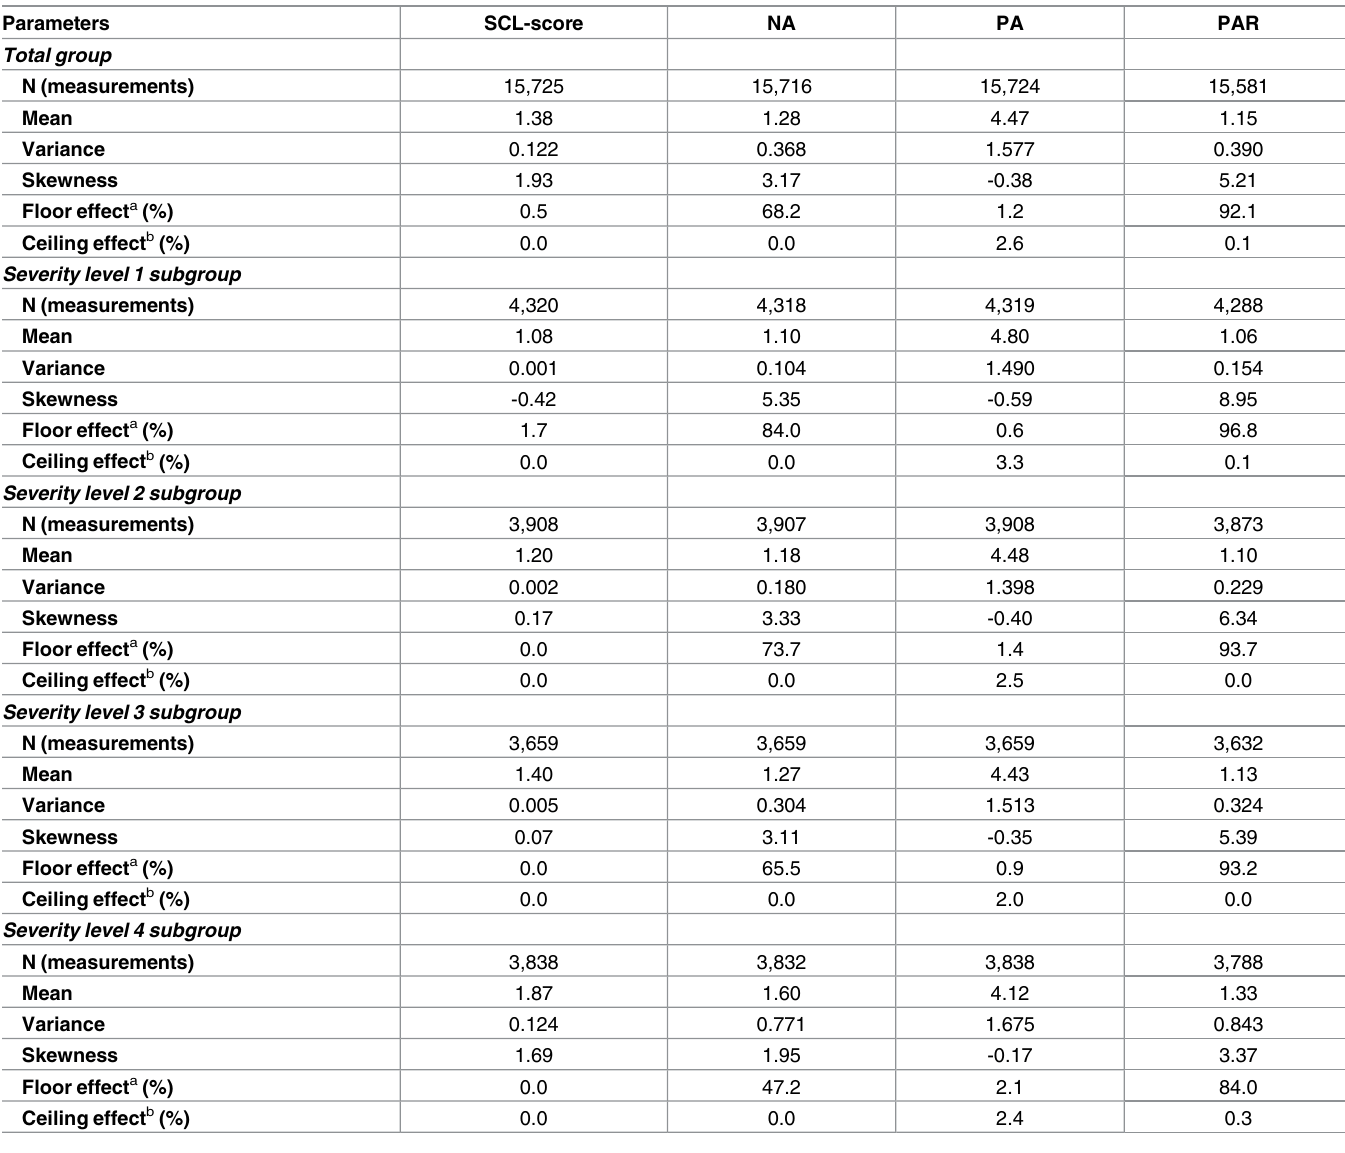
Table 1. Distributional parameters of the variables by severity